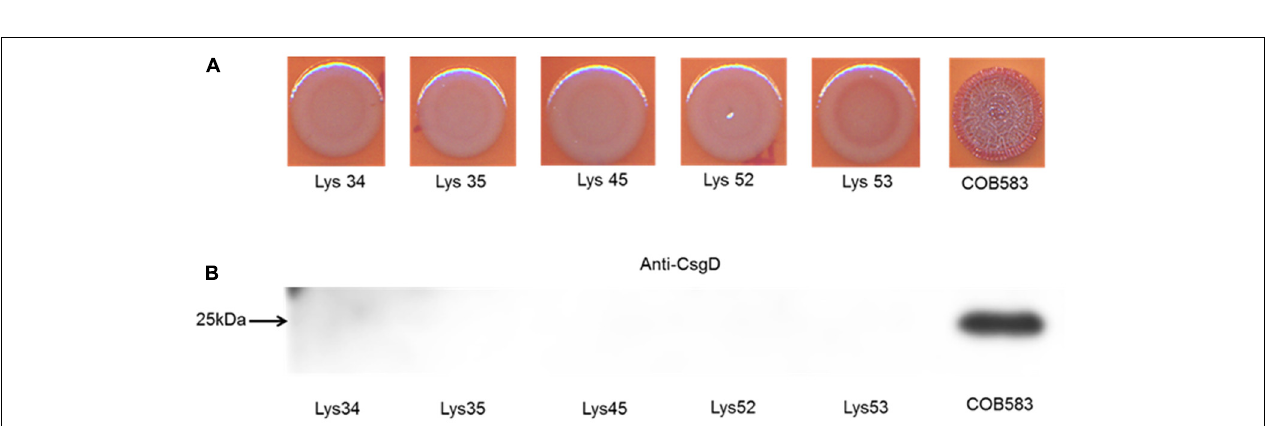
FIGURE 4 | Five additional soil-persistent Escherichia coli with mutations in dgcE and pdeR were curli-negative. (A) Macrocolonies of additional soil-persistent E. coli with the same mutations in the nucleotide sequences of diguanylate cyclase ( dgcE ) and phosphodiesterase ( pdeR ) ( E. coli Lys34, Lys35, Lys45, Lys52, Lys53) with positive control strain (COB583) were grown on Congo Red-containing Yeast Extract and Casamino acid (CR-YESCA) agar at 28 ◦ C for 48 h. (B) Western blotting was done for determining the expression of CsgD under the same conditions described above.